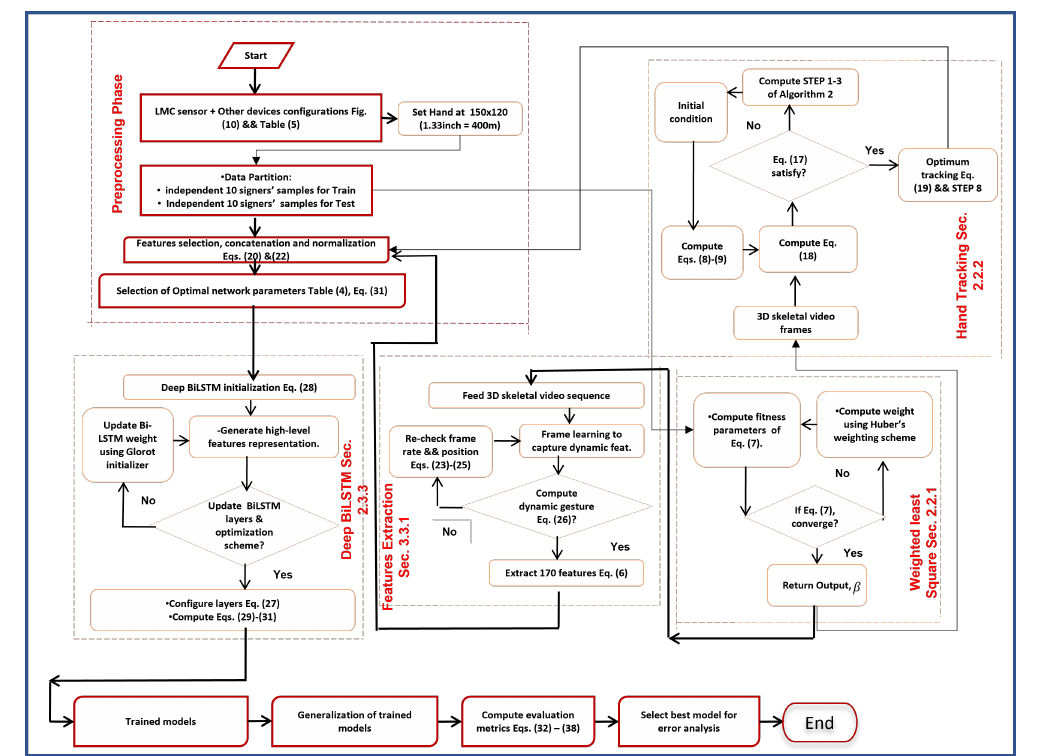
Figure 1. Procedures of the proposed